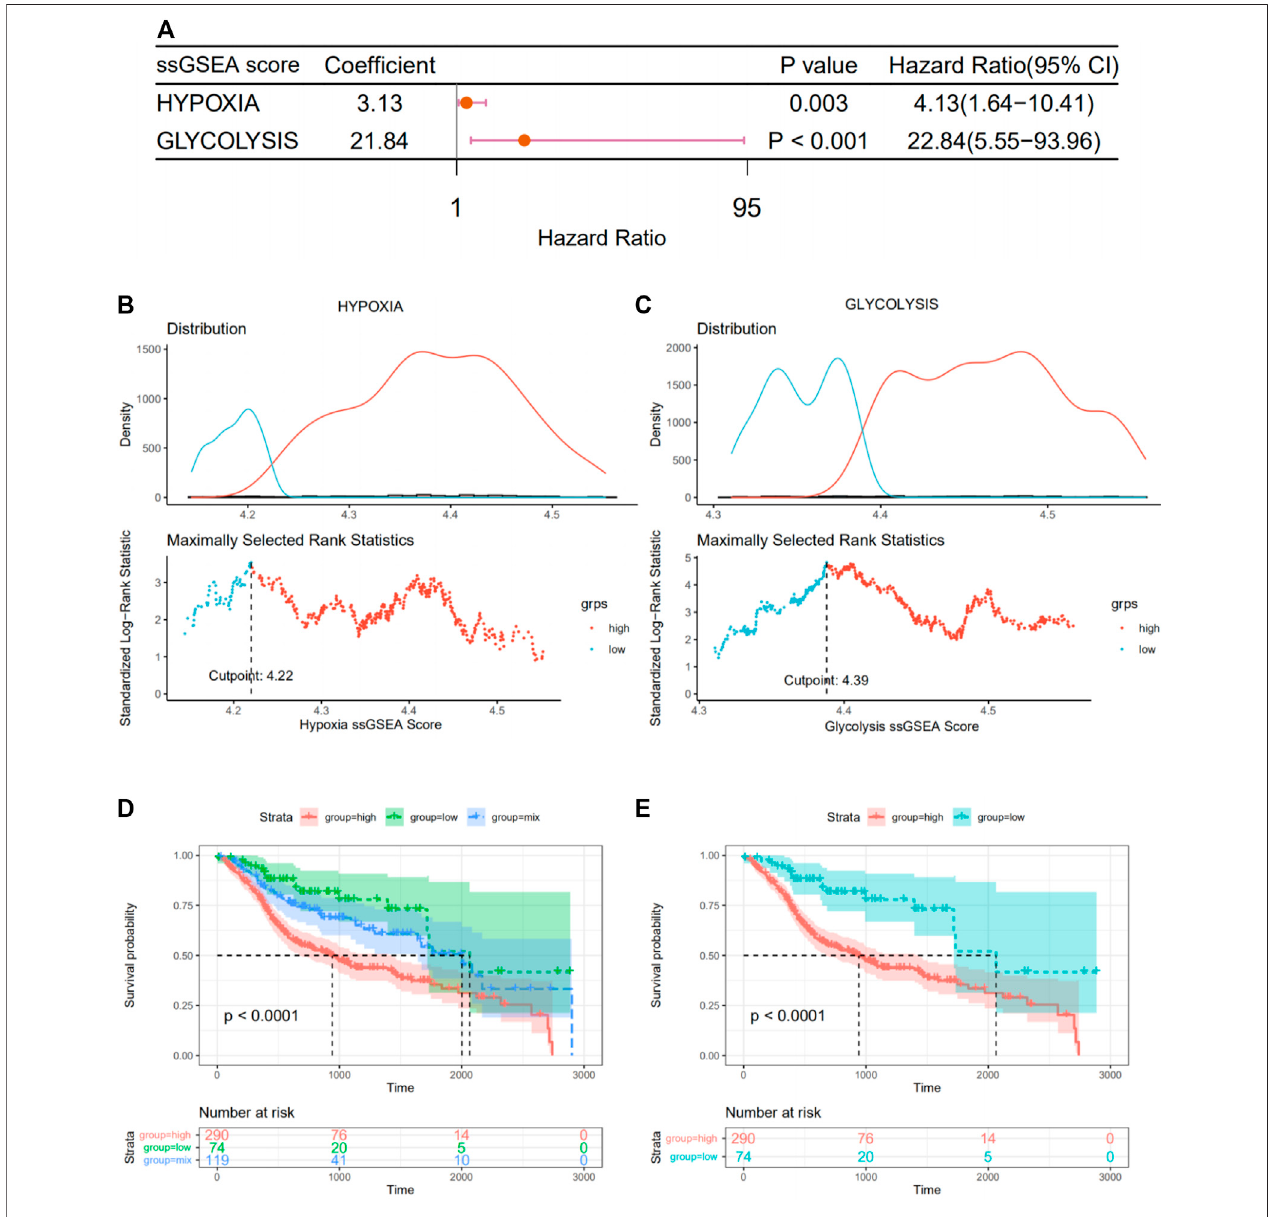
FIGURE3| Groupingofpatientsaccordingtotheirhypoxiaandglycolysisstatus. (A) ForestplotofhypoxiaandglycolysisscoresbyunivariateCoxregression. (B,C) A vertical dashed line was used to mark the cutoff point with the maximum standard log-rank statistic based on hypoxia and glycolysis scores. (D) Kaplan – Meier plot of OS among hypoxia high /glycolysis high , hypoxia low /glycolysis low , and mix groups. (E) Kaplan – Meier plot of OS between hypoxia high /glycolysis high and hypoxia low /glycolysis low .